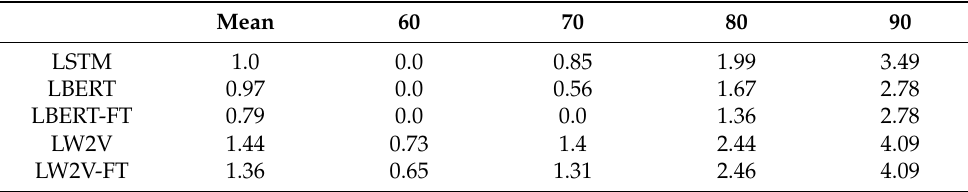
Table 3. Mean and percentiles of the closeness error for predictions (in km).